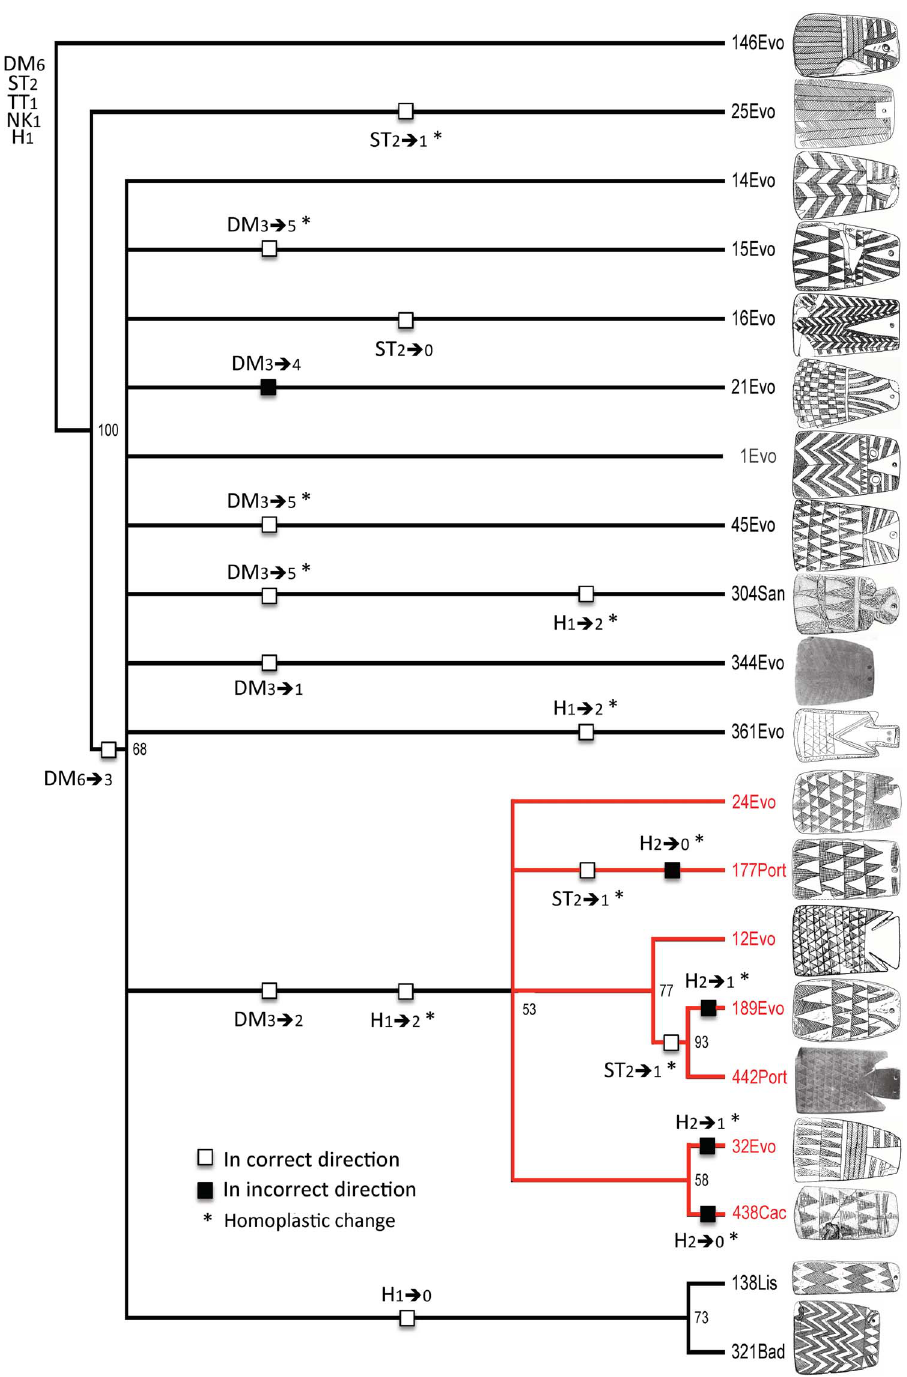
Figure 8. Fifty-percent majority-rule consensus tree from exercise 2, sample 3 (the 2/3 tree) showing character-state changes states according to the assumed polarities for characters DM, ST, and H. Changes of states for characters TT and NK do not appear here because Lillios’s hypothesis makes no assumptions about polarity. Numbers at nodes are bootstrap values.